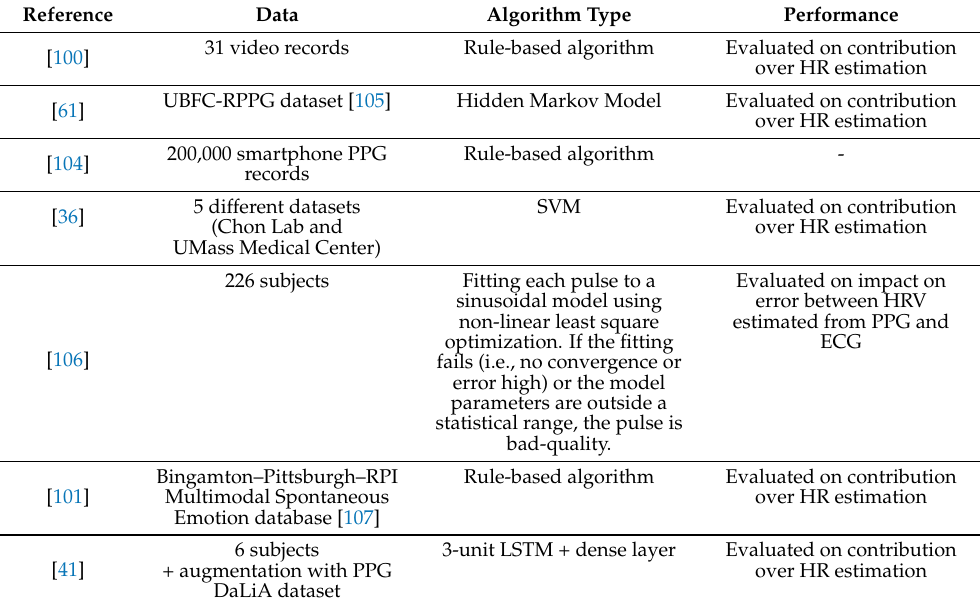
Table 9. Papers dedicated to signal quality indices for